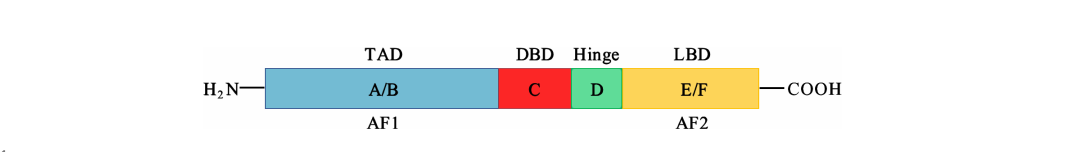
FIGURE 1 The structure of NR4A receptors. NR4A structure has a N-terminal domain containing AF-1, and C-terminal domain with AF-2, they fl ank a DNA-binding domain (DBD) and a hinge